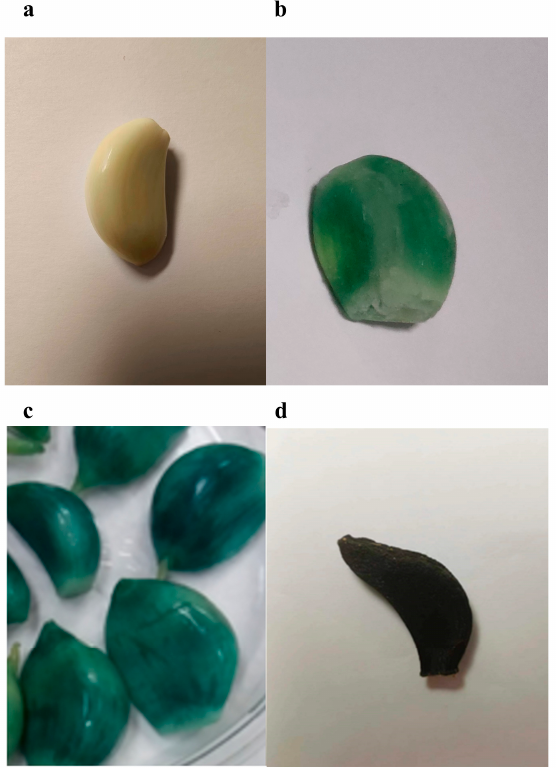
Figure 3. Pictures of four kinds of garlic. ( a ) White garlic, ( b ) green garlic, ( c ) Laba garlic and ( d ) black garlic.